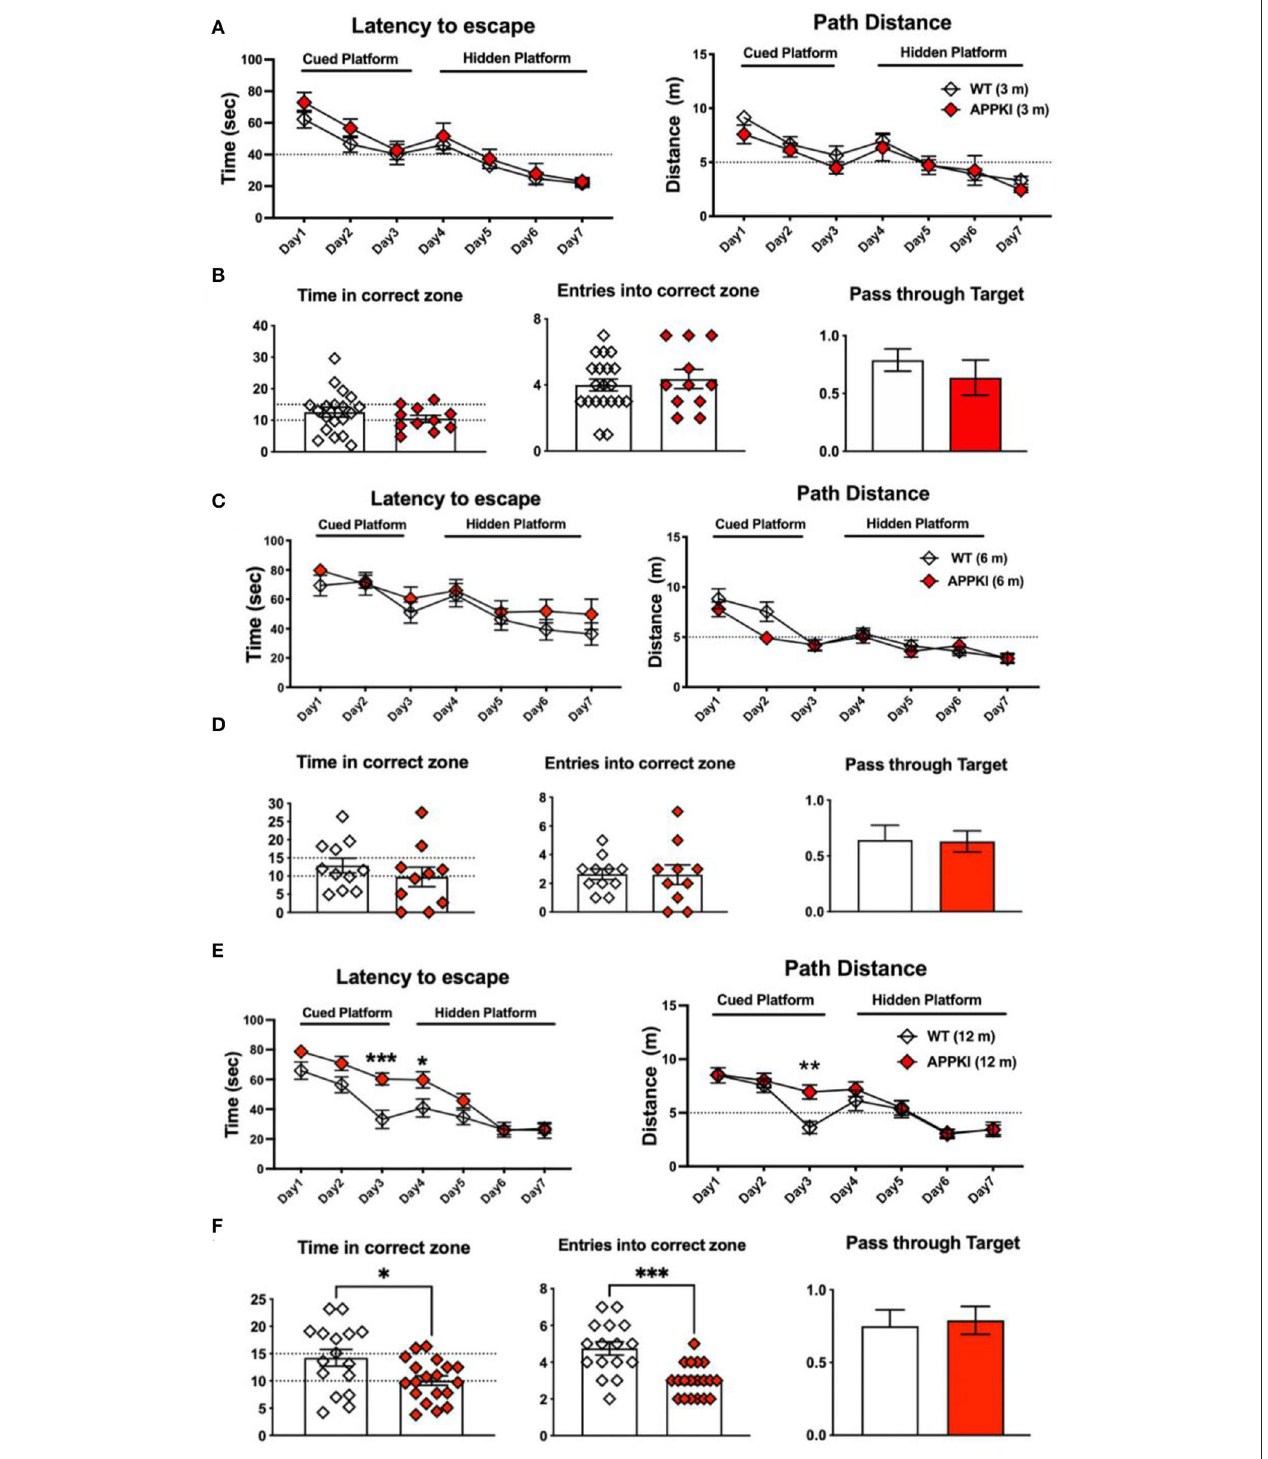
FIGURE 3 | Learning and memory deficit of 3-, 6-, and 12-m APPKI mice by Morris water maze (MWM). (A,C,E) Results of days 1–7 showing time spent to reach platform and distance traveled to reach platform for 3-m, 6-m, and 12-m age of mice, respectively. Cued platform and hidden platform are both submerged underneath the water with or without a visible flag. (B,D,F) Results of day 8 showing the number of times mice entered the platform quadrant and the time spent in that zone, as well as the number of times passing through platform zone. Data are presented as mean ± SEM; n = 11–19 mice per group. Training session (days 1–7) was analyzed by two-way ANOVA followed by Bonferroni’s multiple comparison test; probe session was analyzed by Student’s t -test. Significance was assumed when p < 0.05. * p < 0.05, ** p < 0.01, *** p < 0.005.